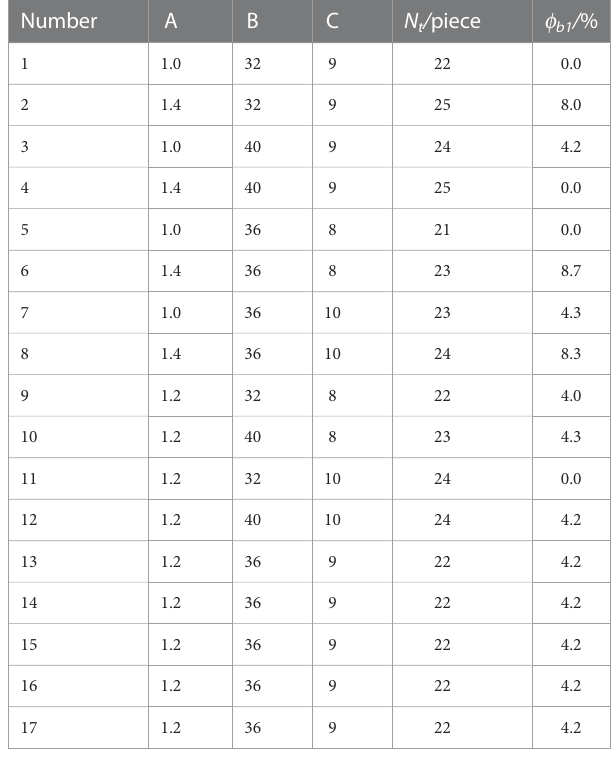
TABLE 5 Results of the shell fi sh harvesting response surface simulation tests.